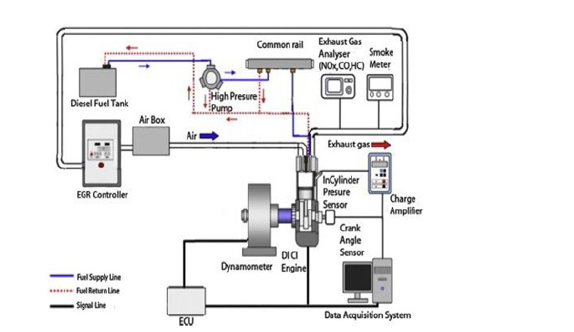
Fig. 1. CRDI Engine with experimental